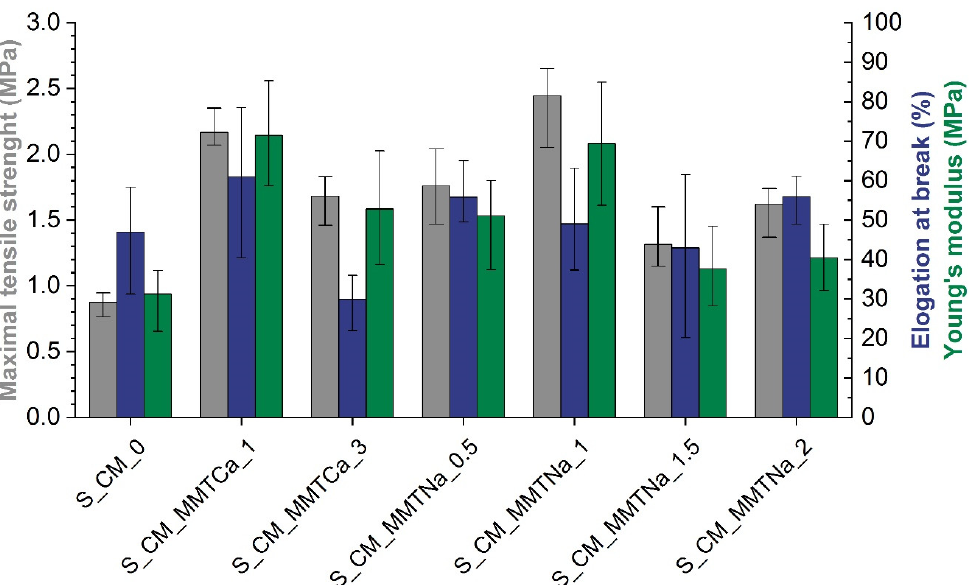
Figure 8. Mechanical properties of starch films with calcium (MMTCa) or sodium (MMTNa) mont- morillonite (gray – maximal tensile strength (MPa), blue – elongation at break (%), green – Young’s modulus (MPa)).